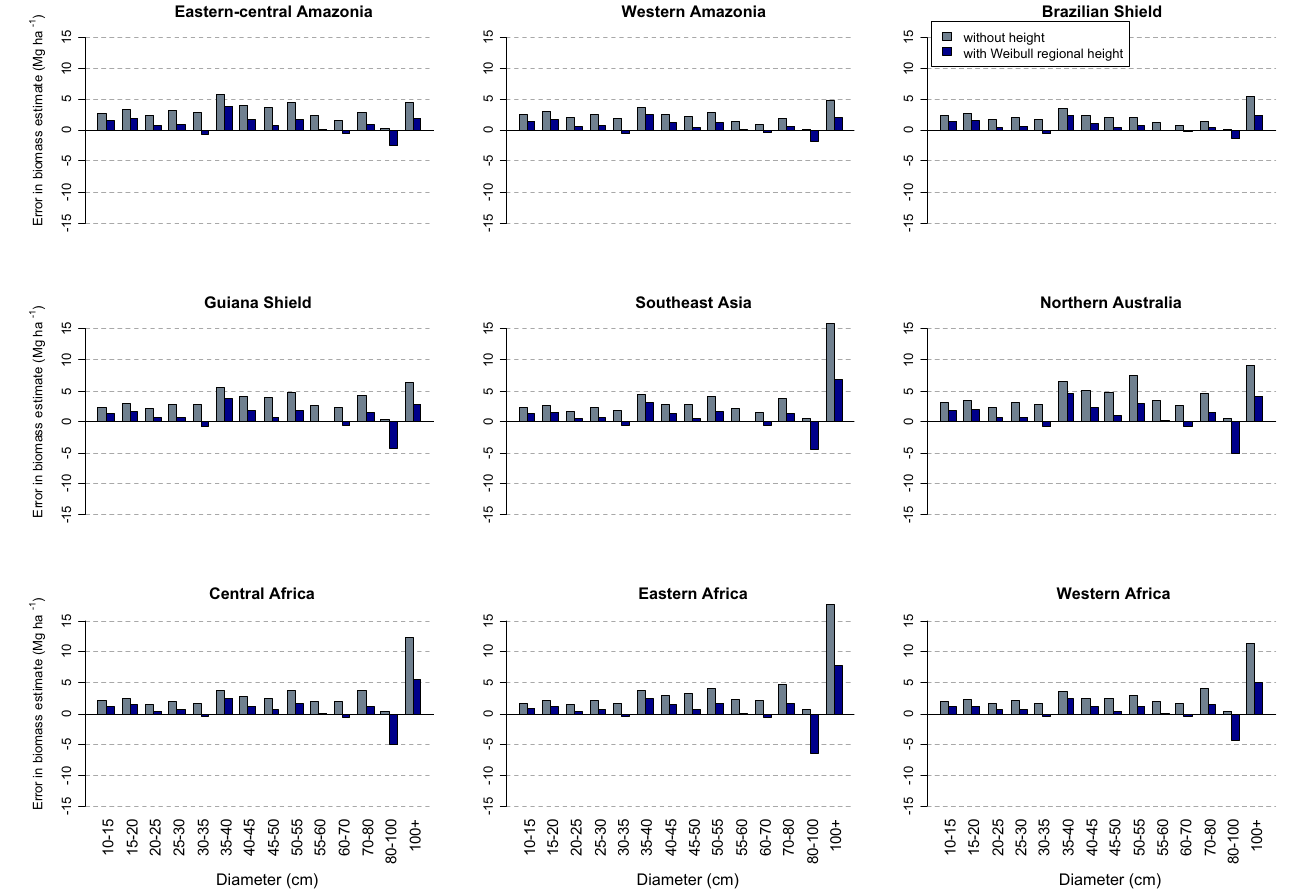
Fig. 4. Error in biomass estimates (Mgha − 1 ) for trees in pantropical permanent plots due to biomass model inputs excluding or including H (relative error propagated from destructive data). Tree-by-tree biomass was estimated by model (1) without H , or model (2) with Weibull (Eq. 5) region-specific H